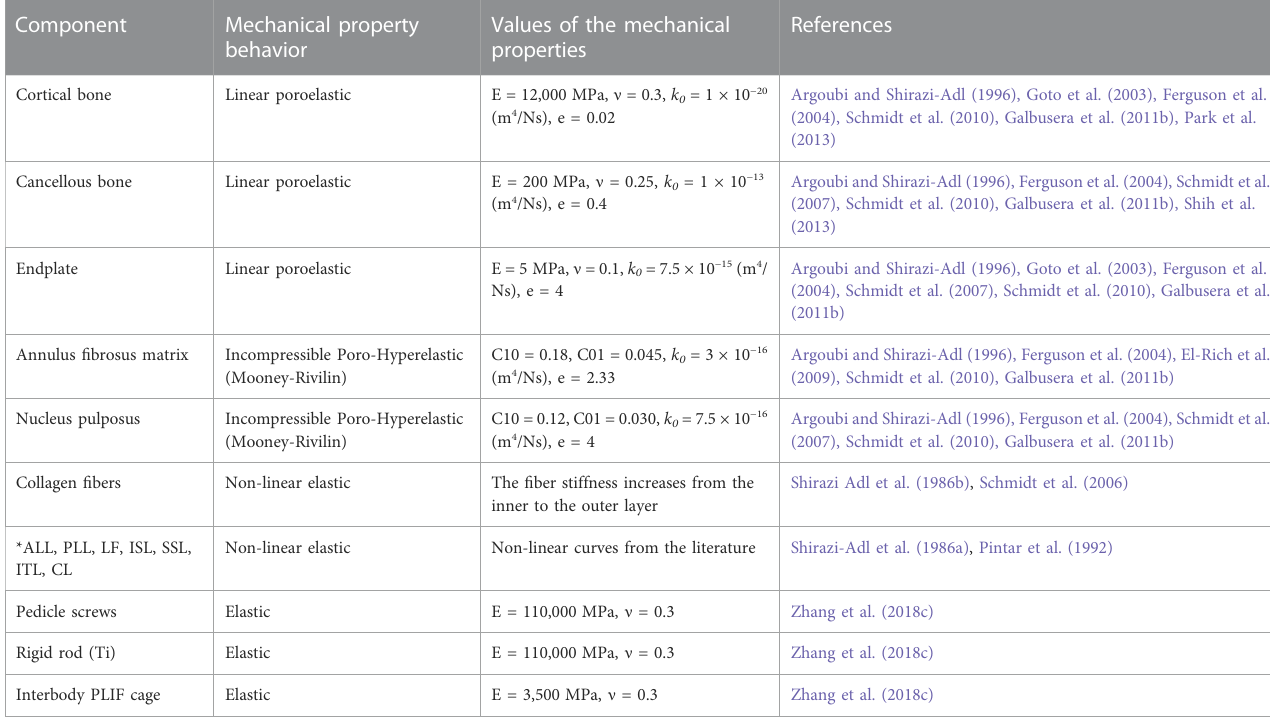
TABLE 1 Mechanical properties of the geometrical personalized poroelastic fi nite element model.